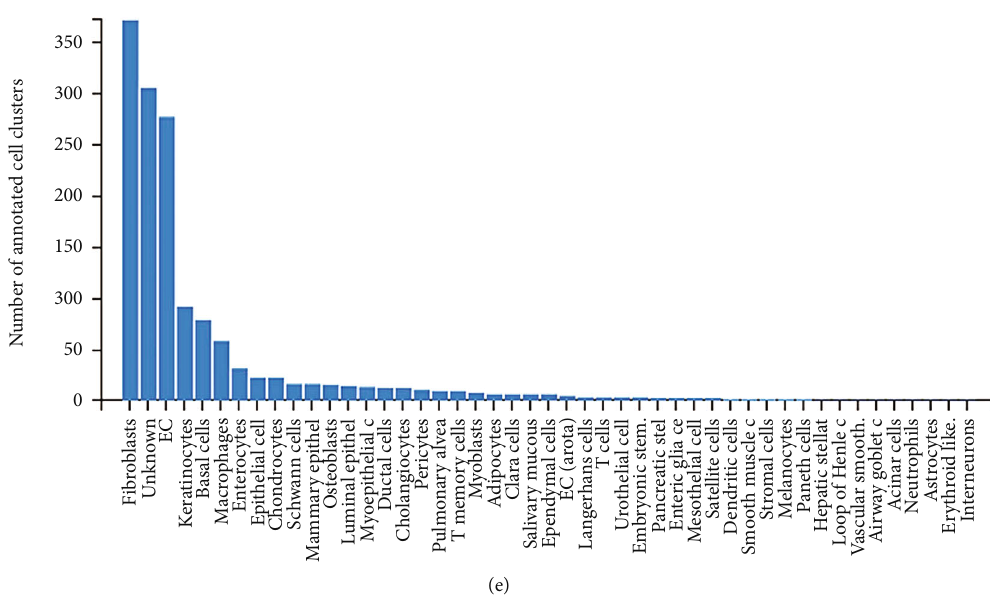
Figure 5: EMP1 expression positively correlated with fi brotic-related genes in liver. Signi fi cant positive correlations of EMP1 expression with fi brotic-related genes including TGFB1 (a), COL1A2 (b), MMP9 (c), and VIM (d), according to the expression pro fi le from GTEx normal liver RNA-sequencing matrix in GEPIA2. (e) Barplot of cell clusters ( y -axis) and cell types ( x -axis) where the gene is expressed. Expression enrichment of EMP1 in di ff erent cell types from 363 scRNA-seq samples and 1487 cell clusters according to PanglaoDB. COL1A2, collagen type i alpha 2 chain; EMP1, epithelial membrane protein 1; GEPIA2, Gene Expression Pro fi ling Interactive Analysis; GTEx, Genotype-Tissue Expression; MMP9, matrix metallopeptidase 9; scRNA-seq, single-cell RNA sequencing; TGFB1, transforming growth factor beta 1; VIM,